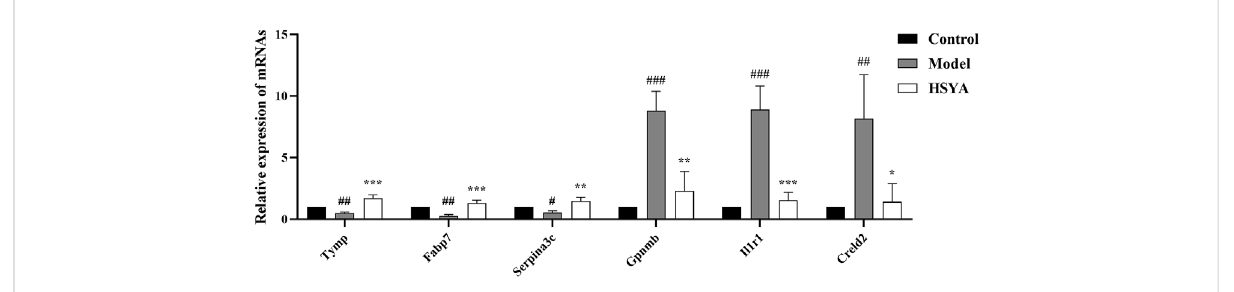
FIGURE 8 Three upregulated DEGs and three downregulated DEGs mRNA expression levels ( (cid:1) x ± s , n = 3). # p < 0.001, ## p < 0.001, ### p < 0.001 vs. the control group; * p < 0.05, ** p < 0.01, *** p < 0.001 vs. the model group.